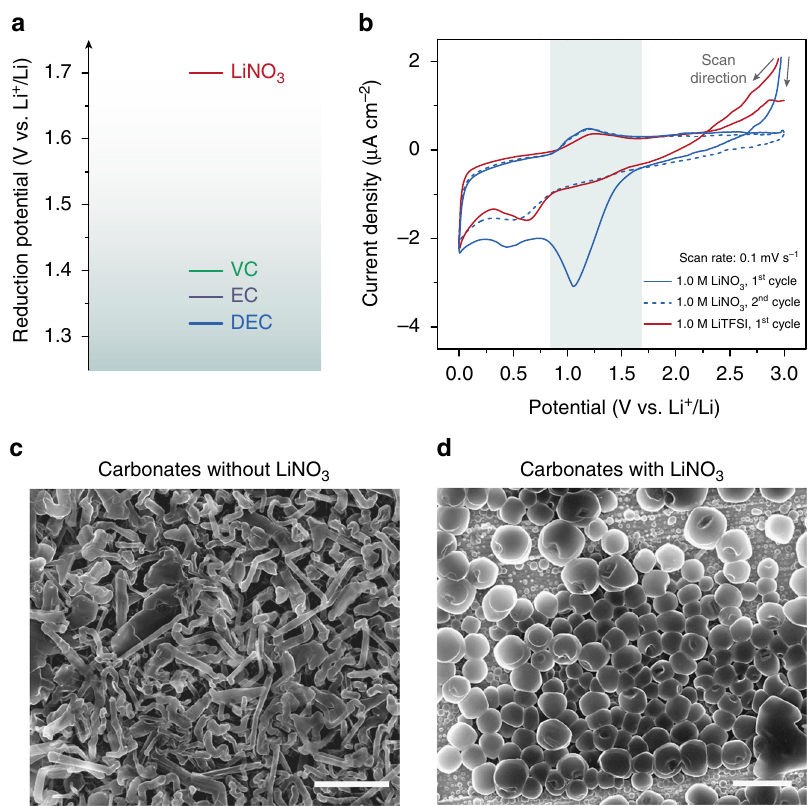
Fig. 1 Preferential reduction of nitrate in carbonate electrolytes alters the Li nucleation morphology. a Experimental reduction potential of various electrolyte components (common solvents like EC and DEC; typical additive VC) on inert electrode reported in the literature 31 . b CV of DME-based electrolytes with 1.0 M LiNO 3 or 1.0 M LiTFSI at a scan rate of 0.1 mV s – 1 . Stainless-steel was used as the working electrode and Li foil was used as the counter/reference electrode. SEM images of the Li nucleation morphology in 1.0 M LiPF 6 EC/DEC electrolyte c without and d with saturated LiNO 3 . Scale bars, 2 μ m. The deposition was carried out at a current density of 1 mA cm – 2 and a capacity of 0.1 mAh cm –